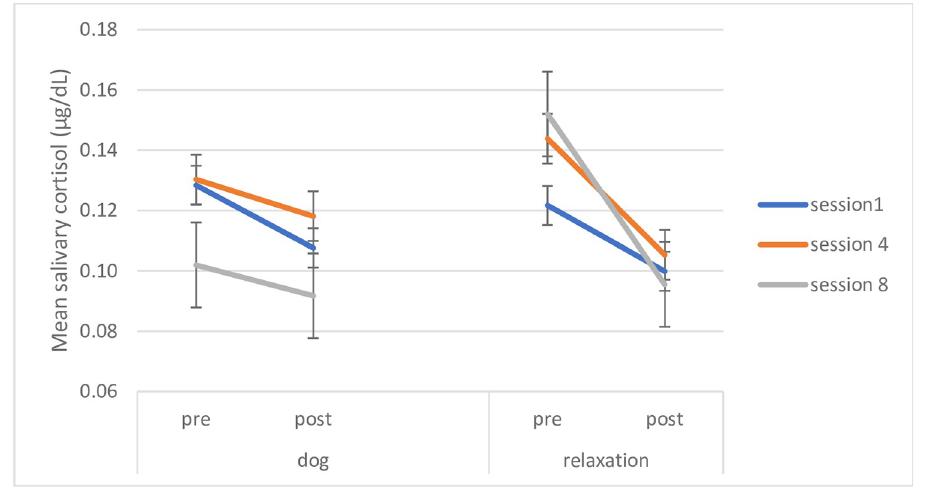
Fig 7. Acute cortisol: Dog and relaxation interventions at sessions week 1, 4 and 8 before and after intervention. Acute cortisol shown for dog and relaxation interventions for sessions in weeks 1, 4 and 8 before and after intervention. Error bars indicate standard error of mean.